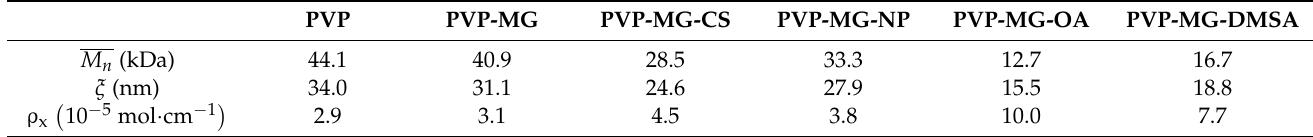
Table 1. M c , ξ and ρ x values for plain and composite PVP membranes.